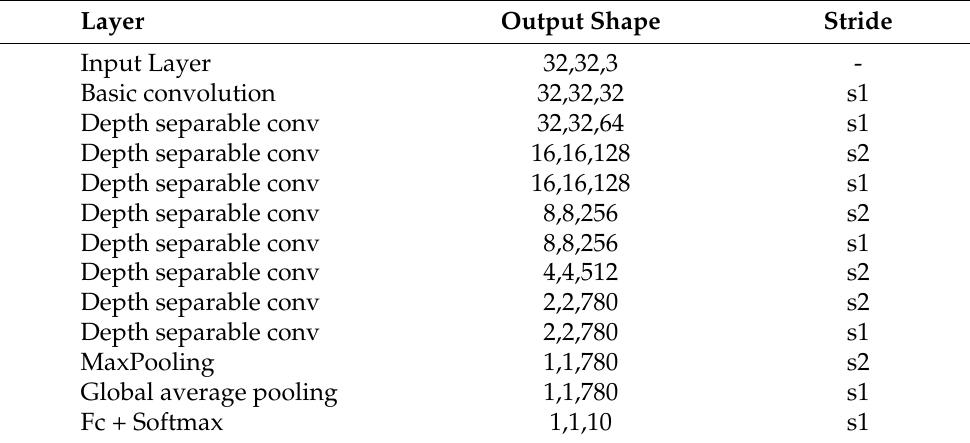
Table 1. Ad-MobileNet structure.